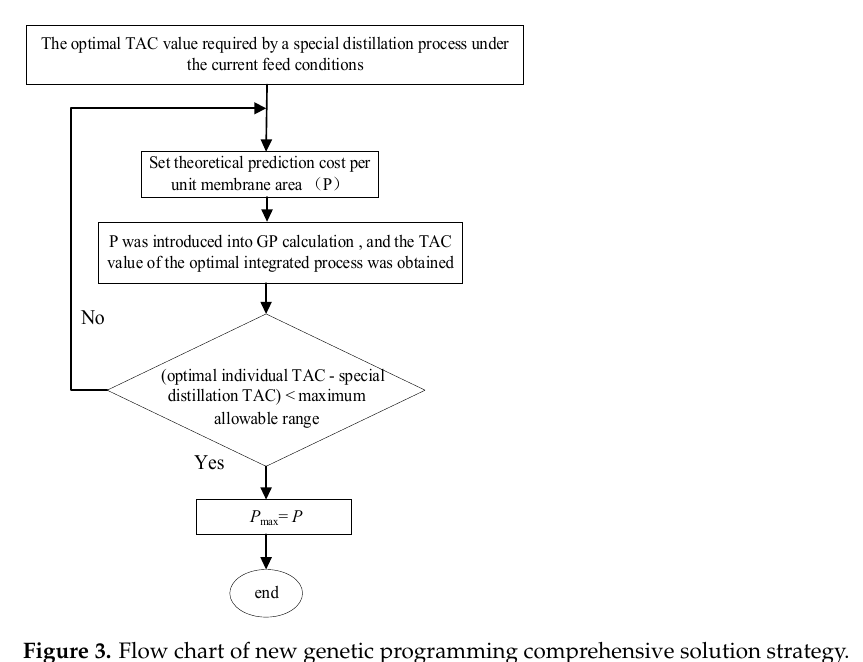
Figure 3. Flow chart of new genetic programming comprehensive solution strategy.